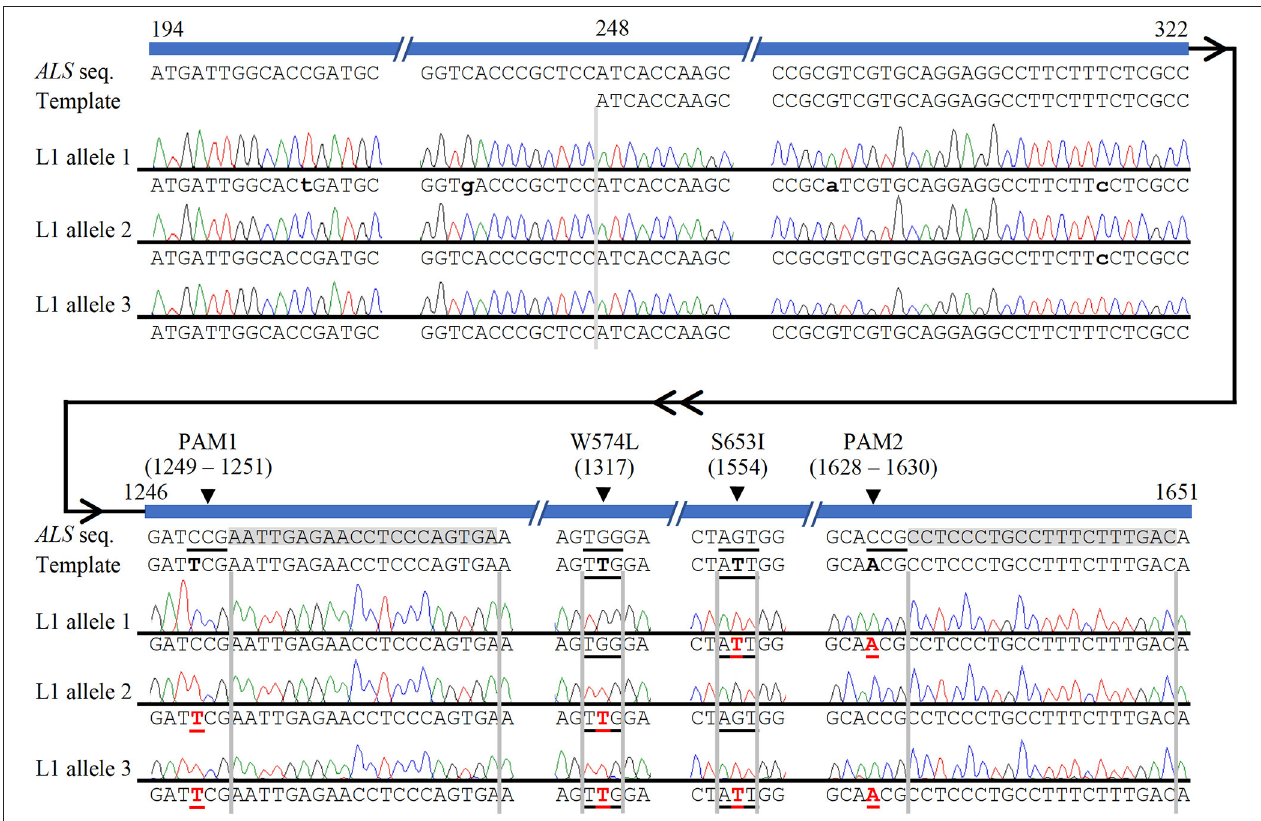
FIGURE 2 | Confirmation of multi-allelic gene targeting in sugarcane by Sanger sequencing of cloned PCR amplicons from ALS alleles. The first 247 bp (194–247 bp shown here) of each cloned ALS amplicons were used to eliminate possible amplification and sequencing of donor template. Naturally occurring non-target single nucleotide polymorphisms, which were used to identify alleles, are indicated with lower case black letters. HDR-mediated CRISPR/Cas9 gene targeting edits are shown in red bold font and underlined. The four targeted nucleotide substitutions are highlighted in the template in black bold font for contrast with the wild-type ALS sequence. The two sgRNA sequences are highlighted in gray. HDR-mediated nucleotide substitutions of S653I and PAM2 (allele 1), W574L and PAM1 (allele 2), or both herbicide resistance sites and both PAM sites (allele 3) are shown in edited line L1. Numbering follows the 1,913 bp PCR amplicon of ALS alleles.